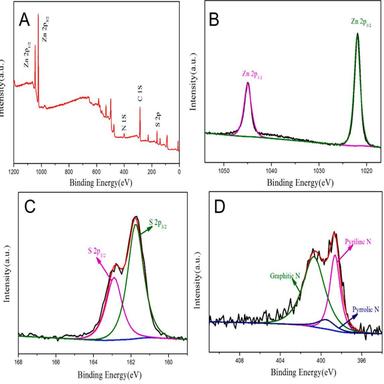
XPS spectra of ZnS/NC composite: (A) survey spectrum; (B) Zn 2p; (C) S 2p and (D) N 1s.